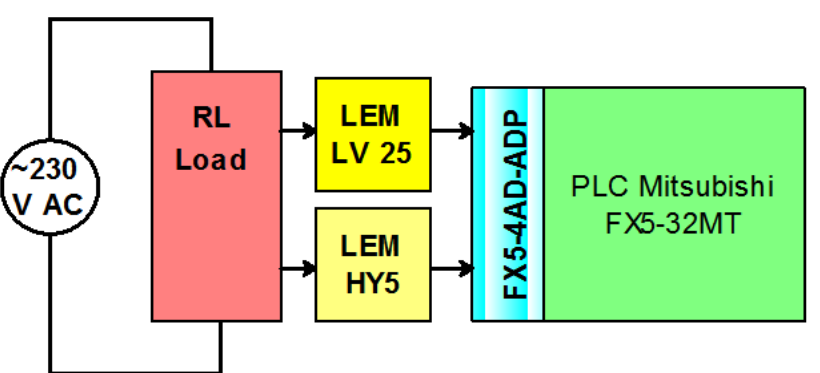
Figure 3. The block diagram of the low-frequency measurement setup for measuring voltage, cur- and power consumption of a single-phase rent, and power consumption of a single-phase load.